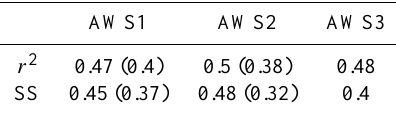
Table 2. Values of SS and r 2 for the three assessed AWSs, averaged over all months of the year, estimated using the entire measuring pe- riods from each AWS, and in brackets the respective values based on period 1 (only for AWS1 and AWS2, because the entire measur- ing period of AWS3 is per definition equal to period 1).